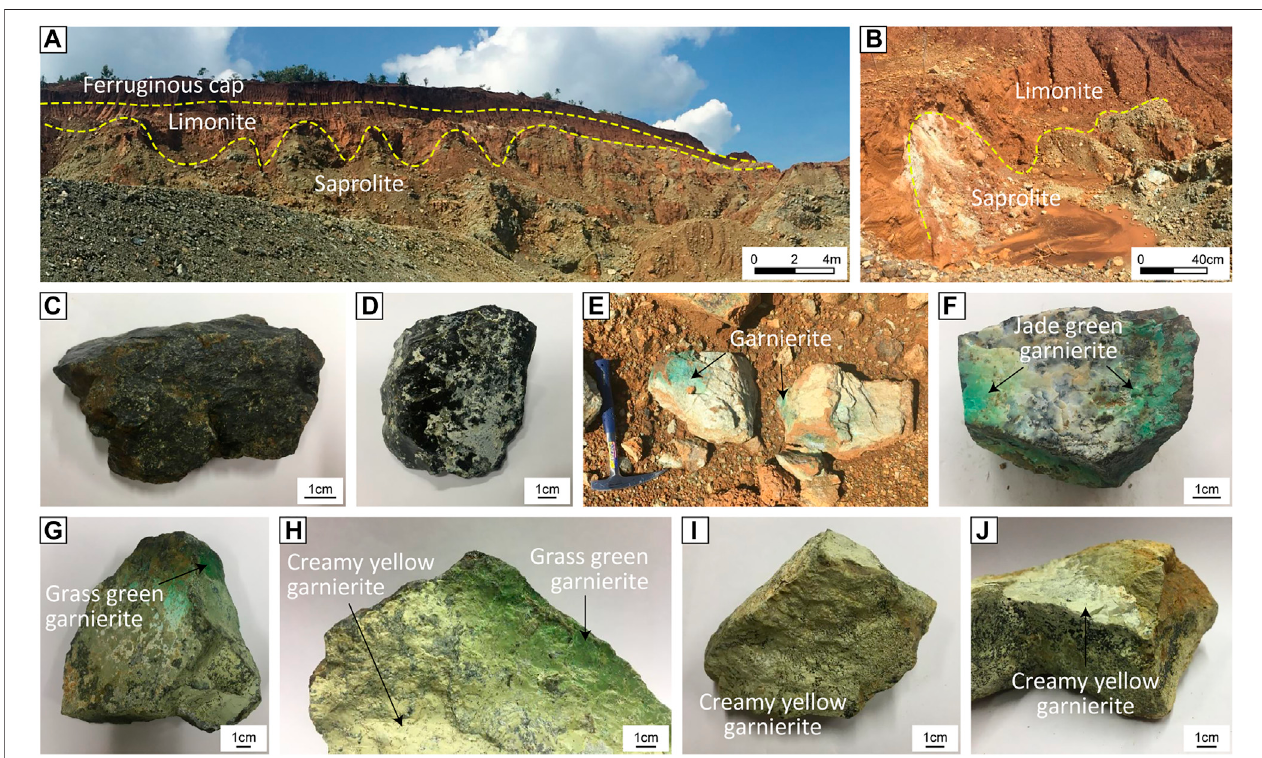
FIGURE 2 | Photographs of lateritic horizons in the Morowali deposit and representative samples from each horizon. Laterite pro fi le (A) and undulatory boundary between limonite and saprolite horizon (B) . Rock samples from bottom to top (C) and (D) bedrock (E) – (J) garnierite samples distinguished by its colors.